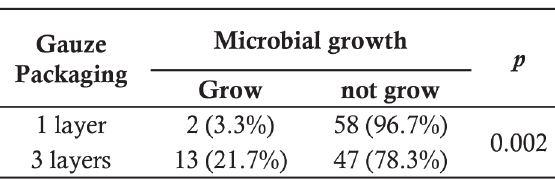
Figure 2. Mechanical folding From Surgical Technology fo r the Surgical Technologist: AP ositive Care Approach (Price 2014, p.157) Differences in microbial growth in Storage duration and microbial the gauze samples